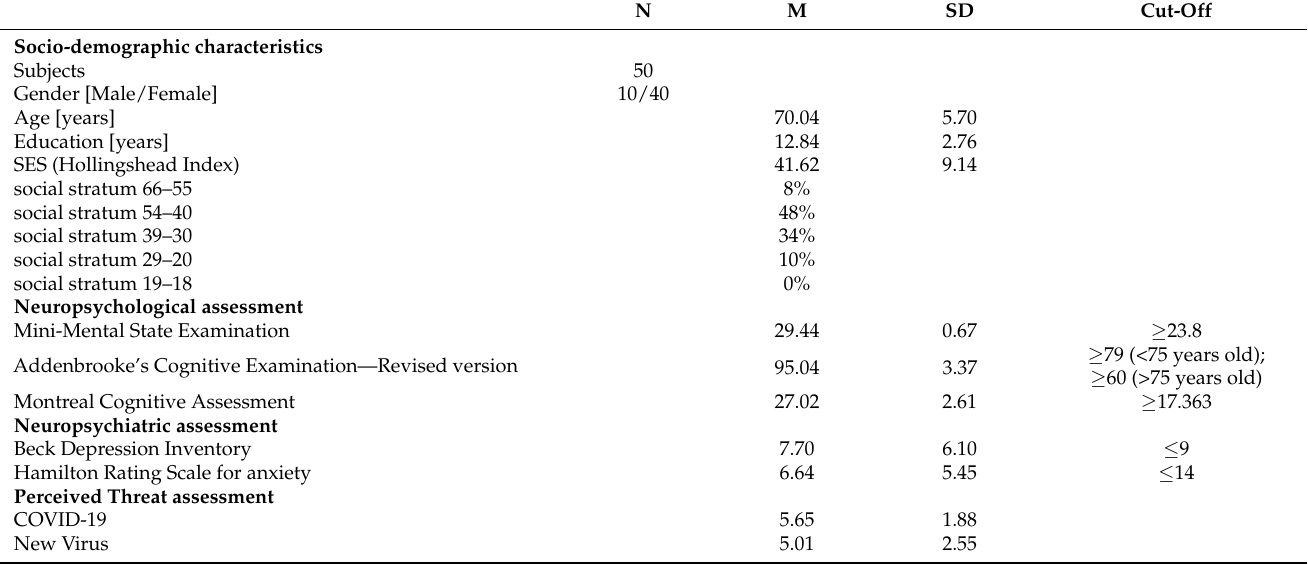
Table 4. Socio-demographic characteristics and neuropsychological assessment (T2). N